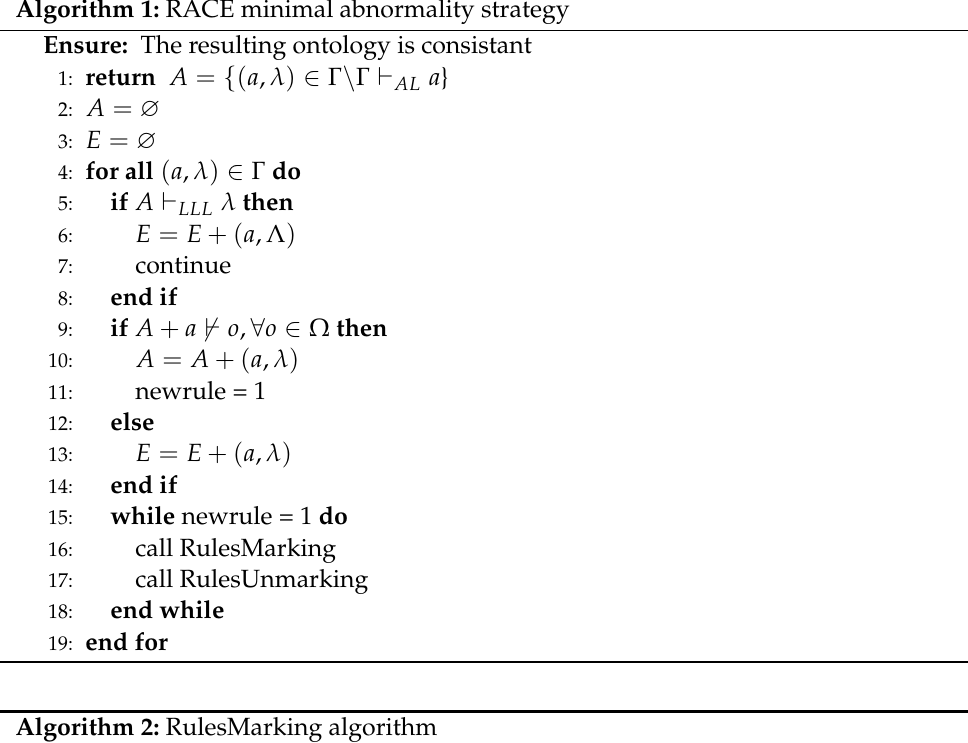
Algorithm 1: RACE minimal abnormality strategy